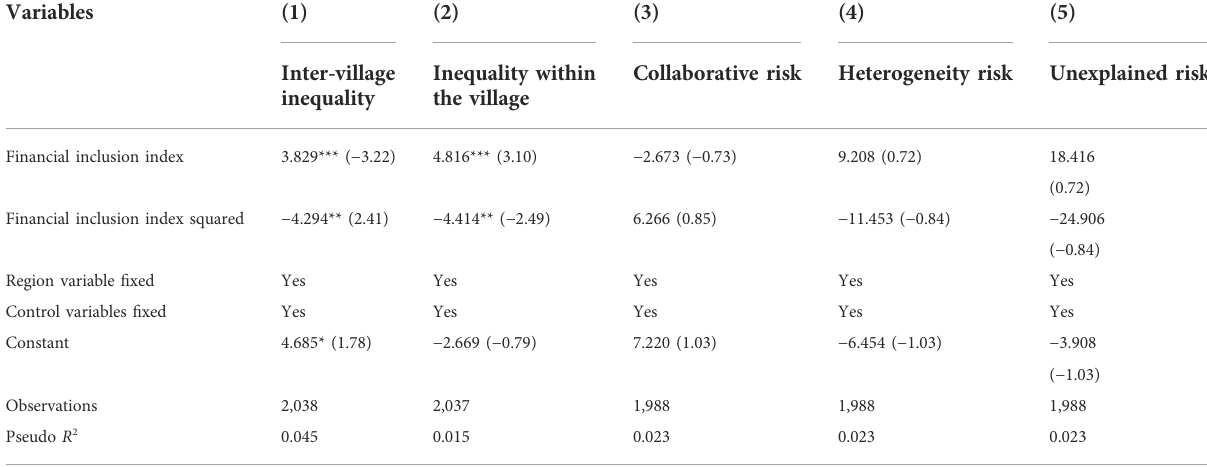
TABLE 7 Model results of fi nancial inclusion on different dimensions of rural household economic vulnerability.